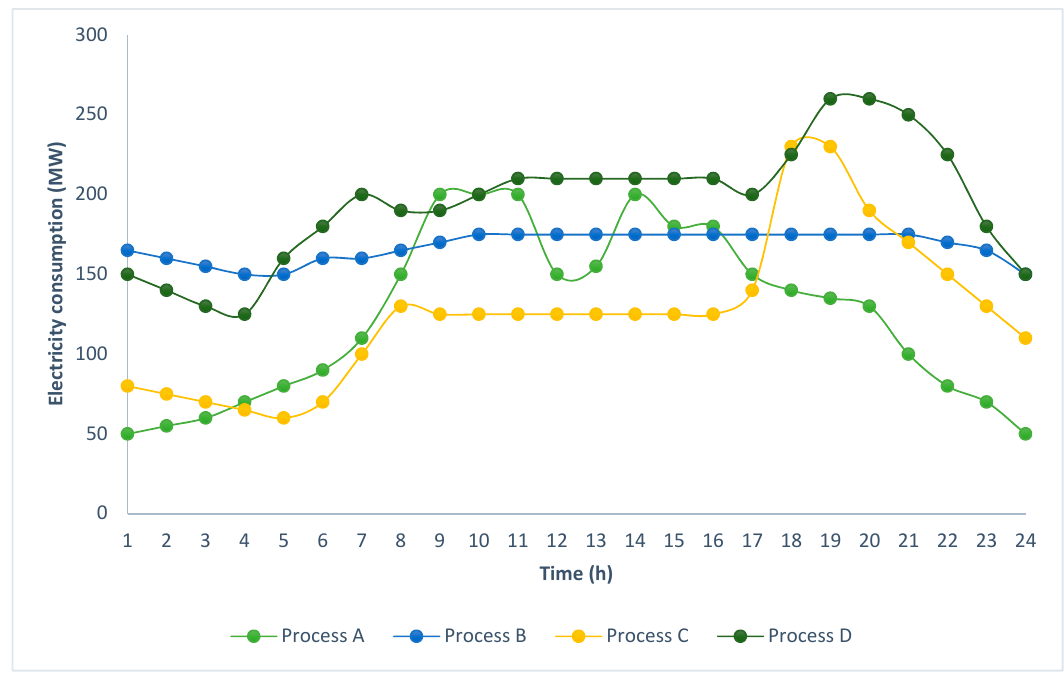
Figure 3. Hourly highest power demands based on industrial plants A (data from Li et al. [62]), B (data from Hobby et al. [63]), C (data from Ho et al. [20]), and D (data from Li et al. [62]).